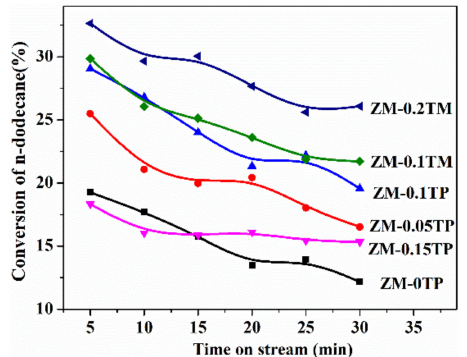
Figure 7. Catalytic conversion of the supercritical n -dodecane cracking over the zeolite